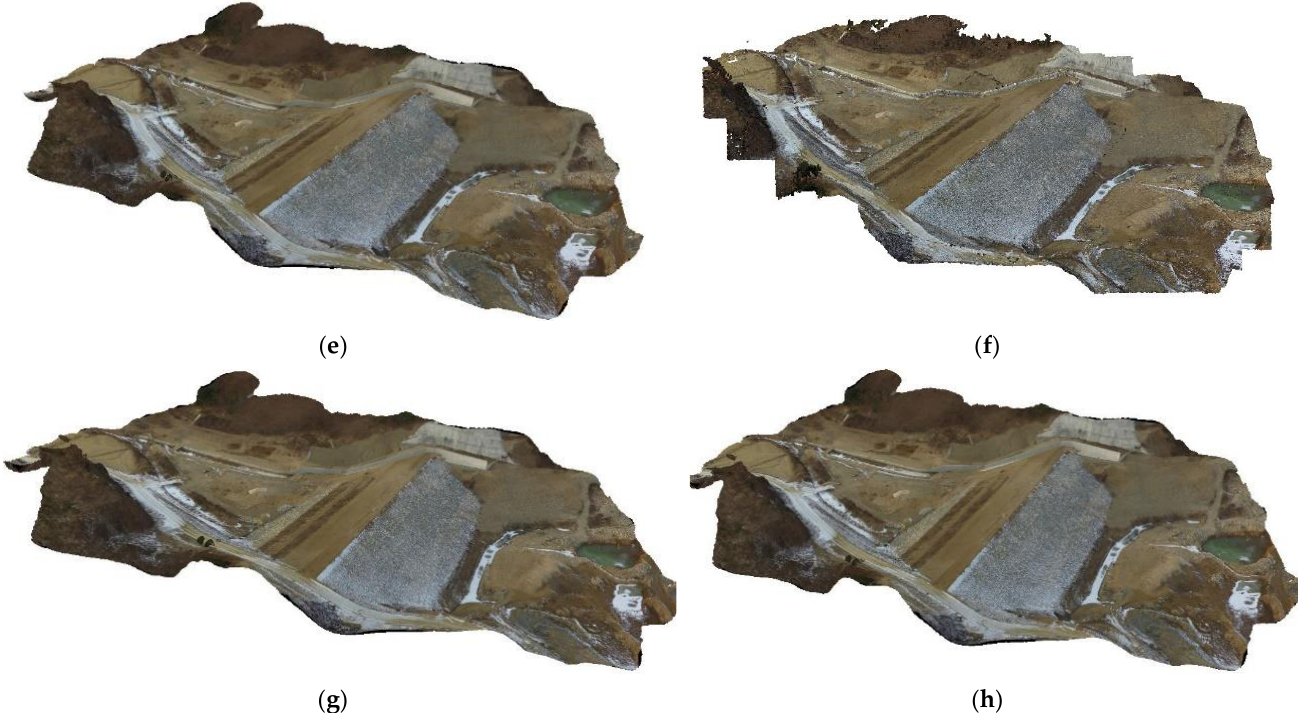
Figure 6. Three-dimensional (3D) model results: ( a ) case 1, ( b ) case 2, ( c ) case 3, ( d ) case 4, ( e ) case 5, ( f ) case 6, ( g ) case 7 and ( h ) case 8.